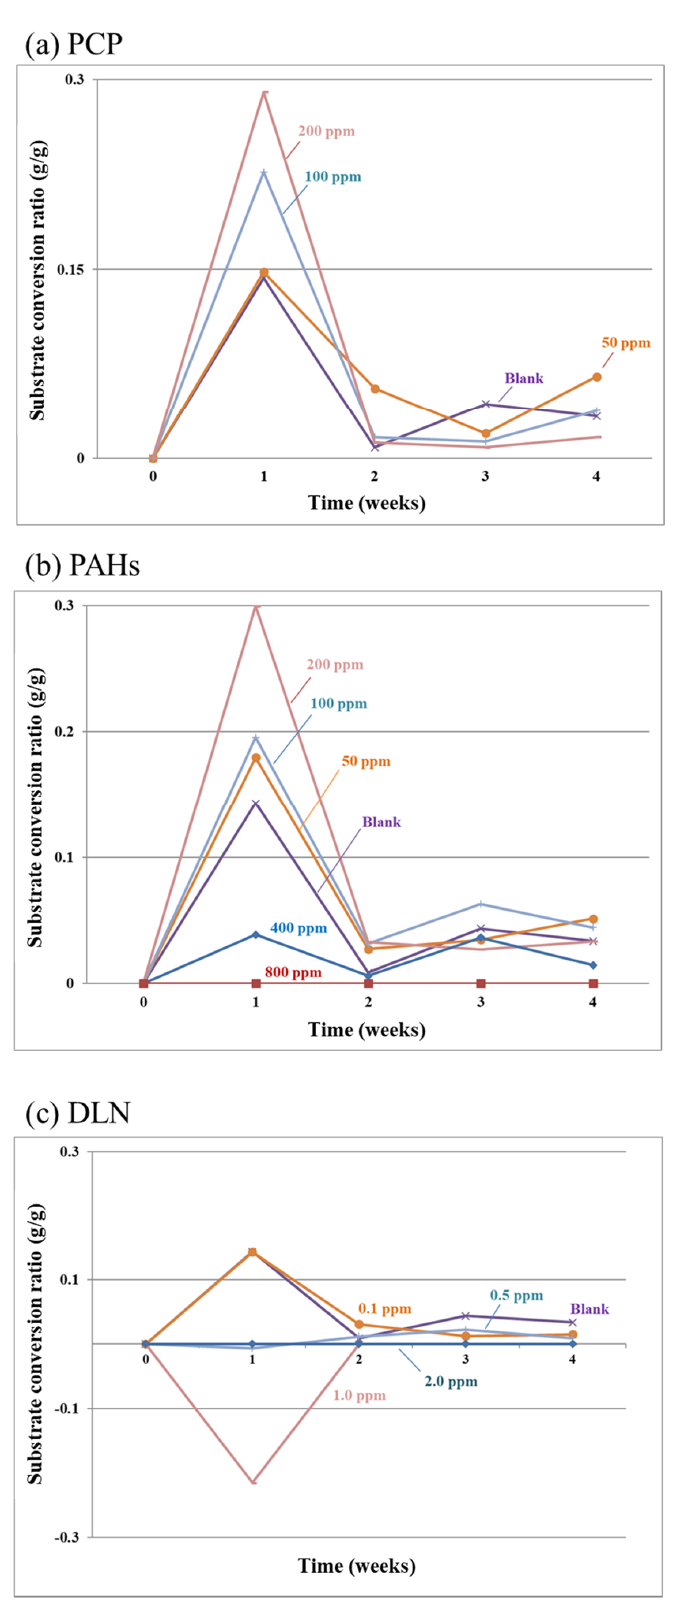
Figure 4. Substrate conversion ratio in the presence of the tested PCP, PAHs and DLN, as labeled in ( a – c ), respectively.